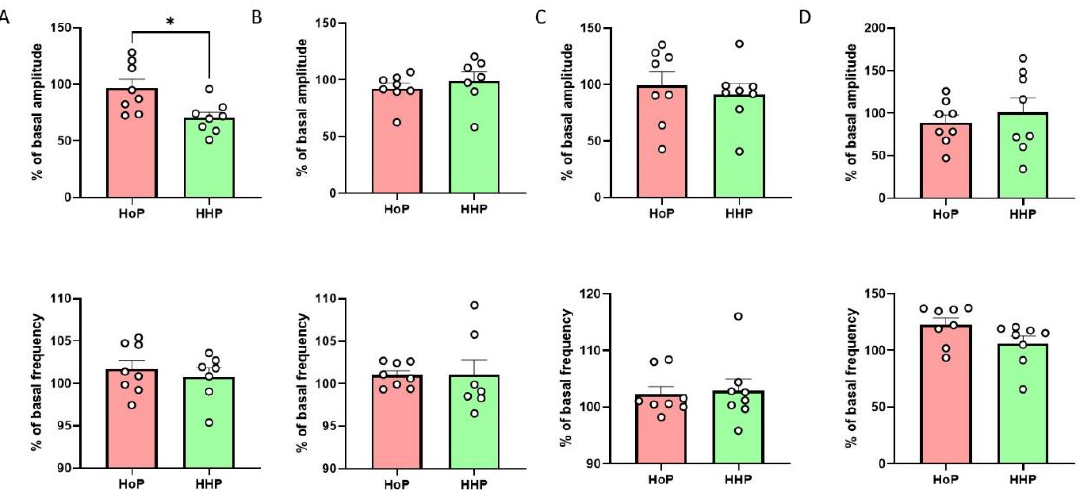
Figure 2. HHP-BM decreases duodenal contraction amplitude. Ex vivo measurement of duodenum ( A ), jejunum ( B ), ileum ( C ) and colon ( D ) mechanical contraction amplitude and frequency in response to HoP- or HHP-BM added in the medium (100 µL, n = 7 – 8). Results are expressed as a percentage of the basal contractions amplitude or frequency. * p < 0.05 compared to HoP-BM.